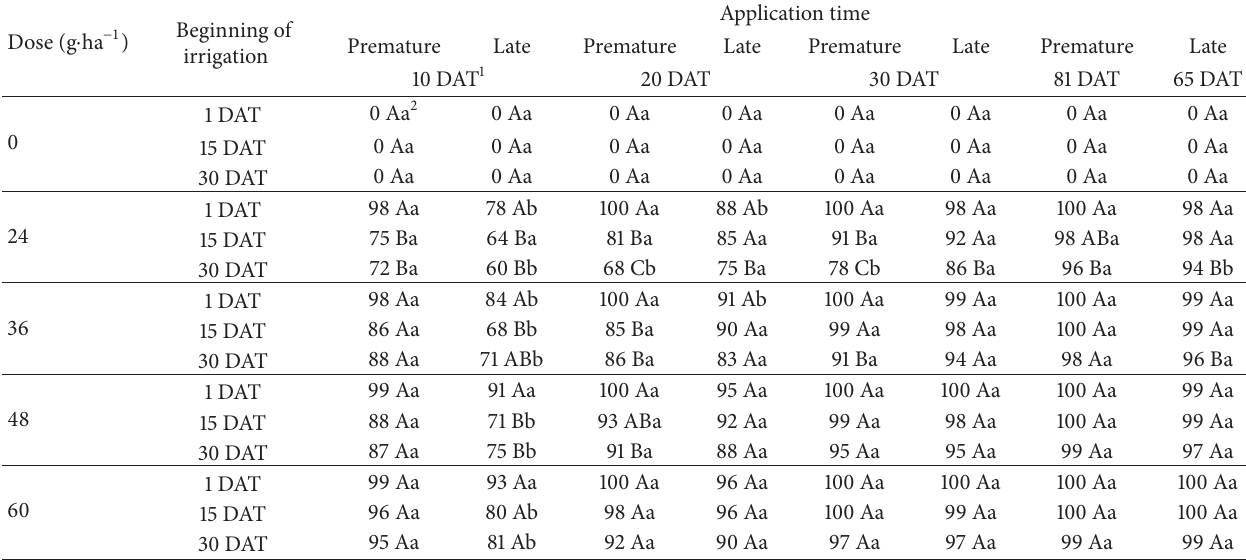
Table 1: Percentage control Echinochloa sp. (barnyardgrass) in irrigated rice, due to periods of flooding, application times, and doses of penoxsulam, Rio Grande, RS,